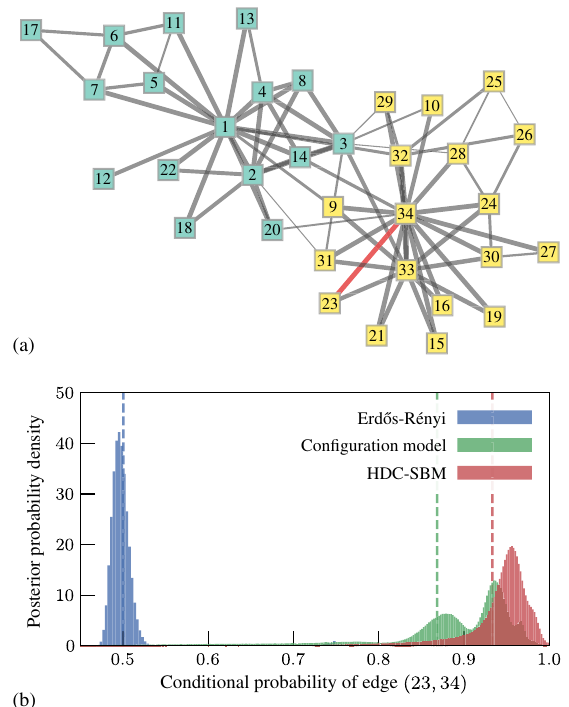
FIG. 3. Inferred Zachary ’ s karate club network using the uncertain data from the original publication [29], which contain an ambiguous edge (23,34), as explained in the text. (a) Layout of the reconstructed network showing the posterior edge probabil- ities as edge thickness, according to the HDCSBM, and the ambiguous edge in red. The node colors correspond to a sample from the posterior distribution of the node partitions. (b) Posterior probability density of the probability of edge (23,34), conditioned on the remaining edges and model parameters, for the different model variants indicated in the legend and explained in the text. The vertical dashed lines indicate the distribution averages, corresponding to the marginal posterior probability of the